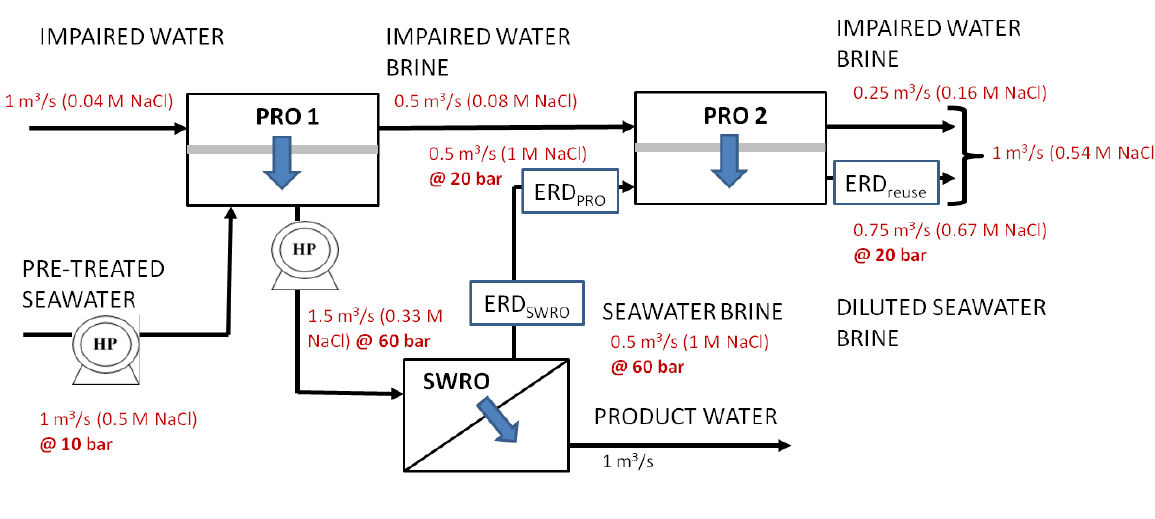
Figure 7. Configuration forward osmosis (FO) 1, diluted seawater water feed using impaired water (water reuse brine) with an FO process and single-stage recovery of osmotic